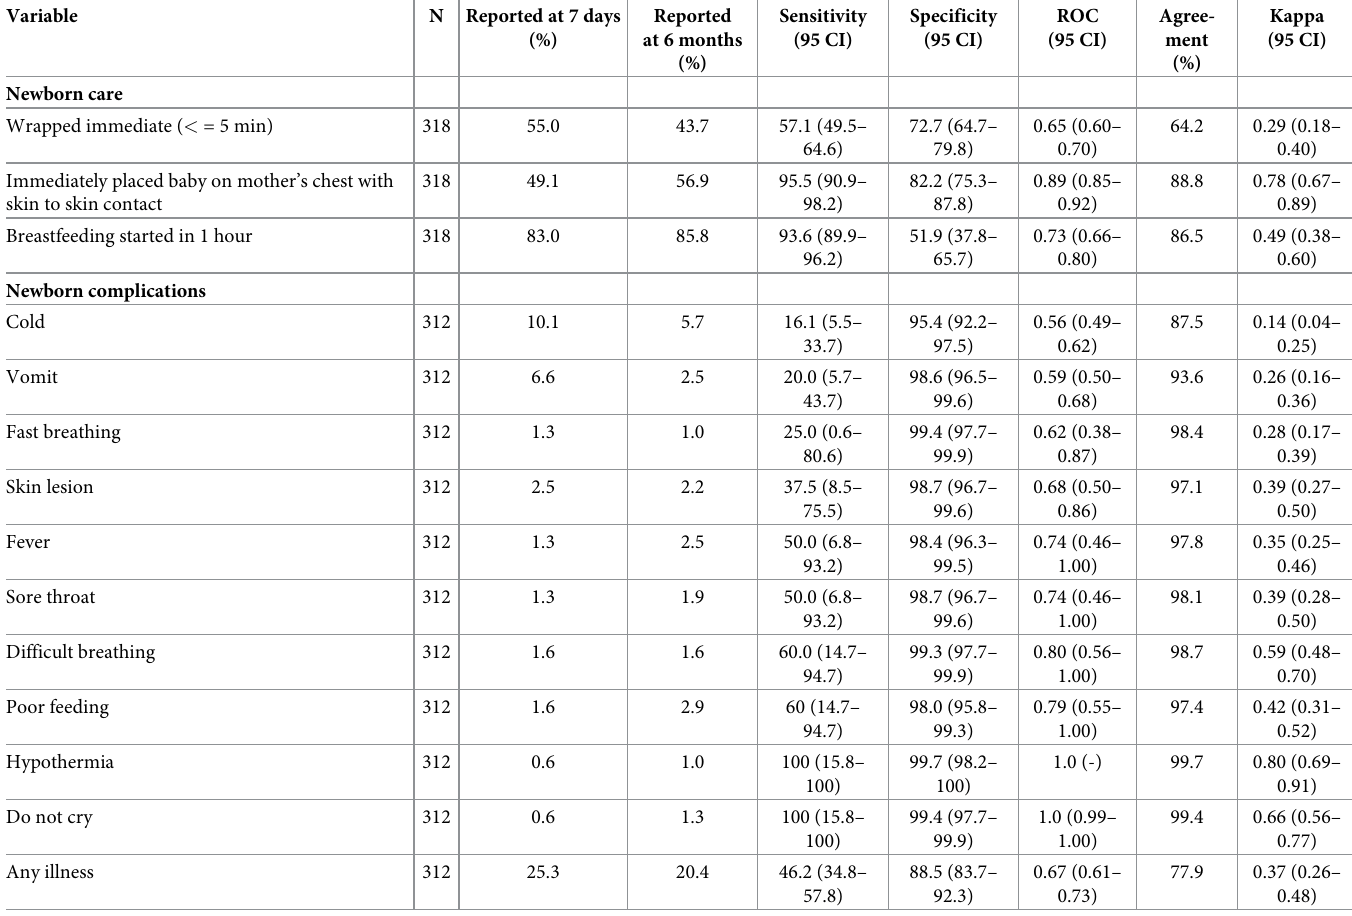
Table 7. Agreement diagnostics for select neonatal interventions and symptoms reported at 7-day and 6-month follow-up visits.